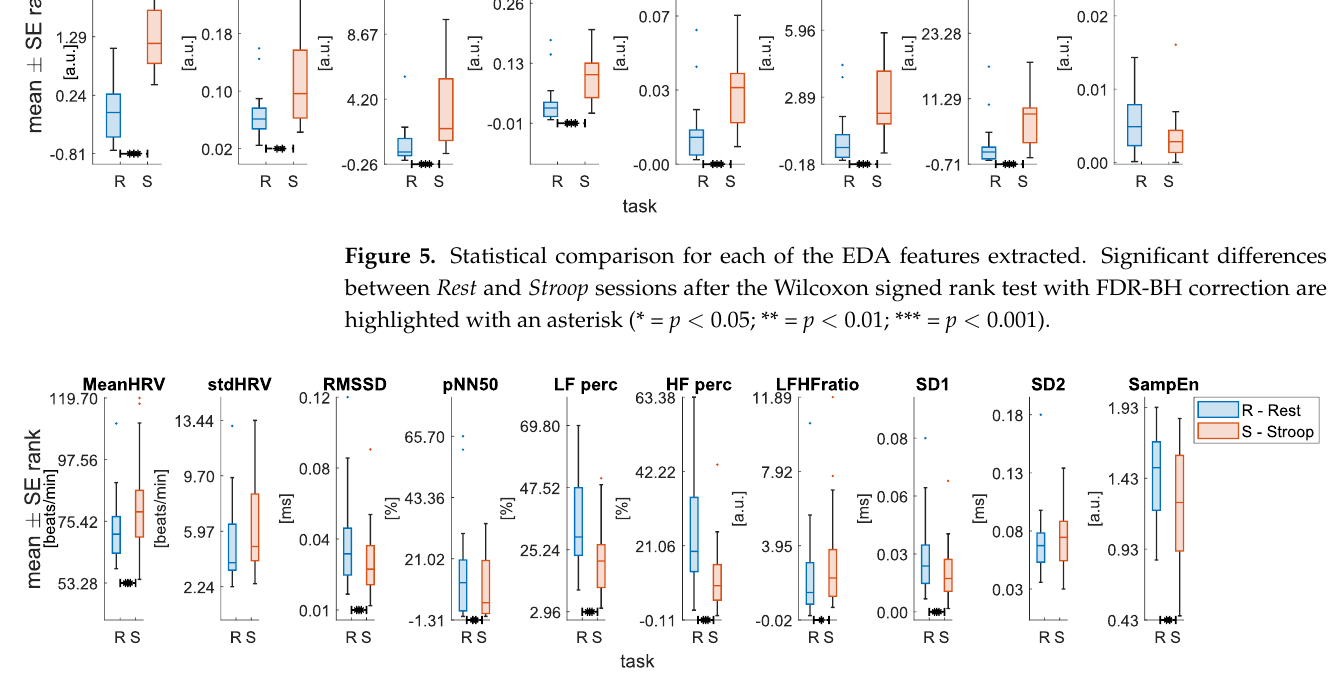
Figure 6. Statistical comparison for each of the HRV features extracted. Significant differences between Rest and Stroop sessions after the Wilcoxon signed rank test with FDR-BH correction are highlighted with an asterisk (* = p < 0.05; ** = p < 0.01; *** = p <